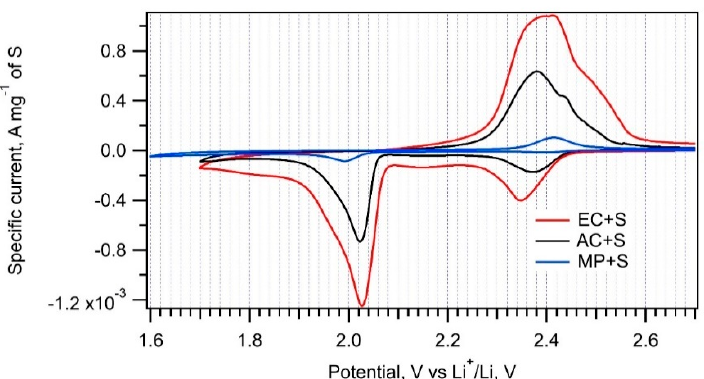
Figure 6. Cyclic voltammograms of the EC + S, AC + S, and MP + S samples recorded with a scan rate of 0.1 mV s − 1 .